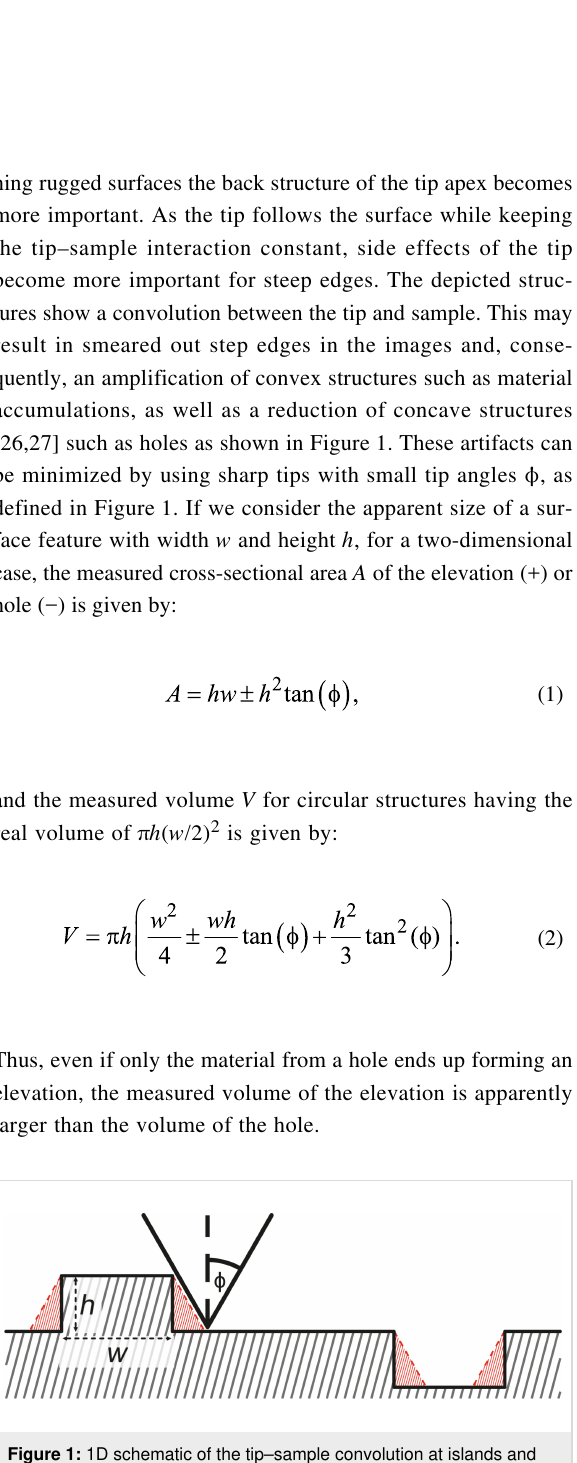
Figure 1: 1D schematic of the tip–sample convolution at islands and holes. Due to the tip geometry step edges appear smeared out. Consequently, accumulations appear to be larger and holes smaller. The red hatched areas show the misassigned volumes at step